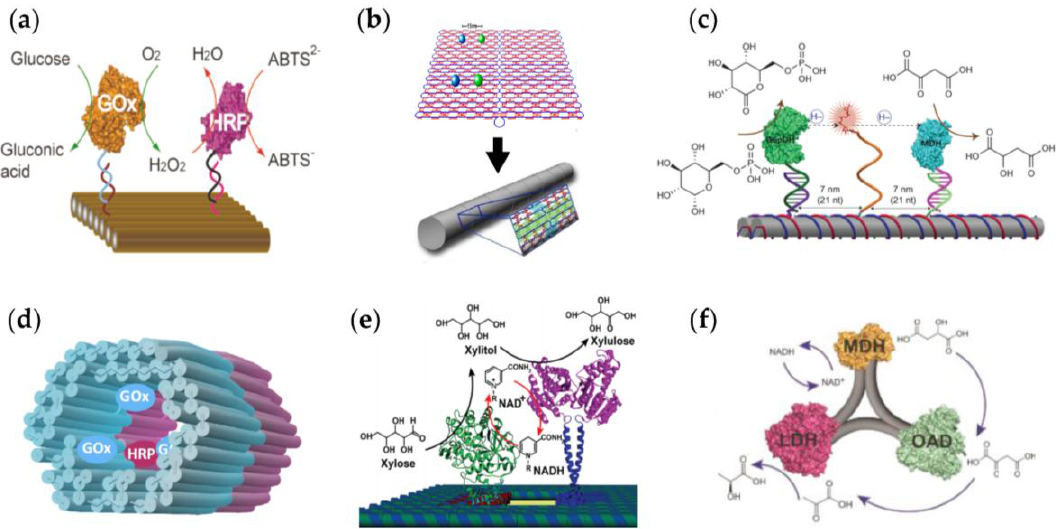
Figure 3. ( a ) A glucose oxidase (GOx) – horseradish peroxidase (HRP) enzyme cascade pair